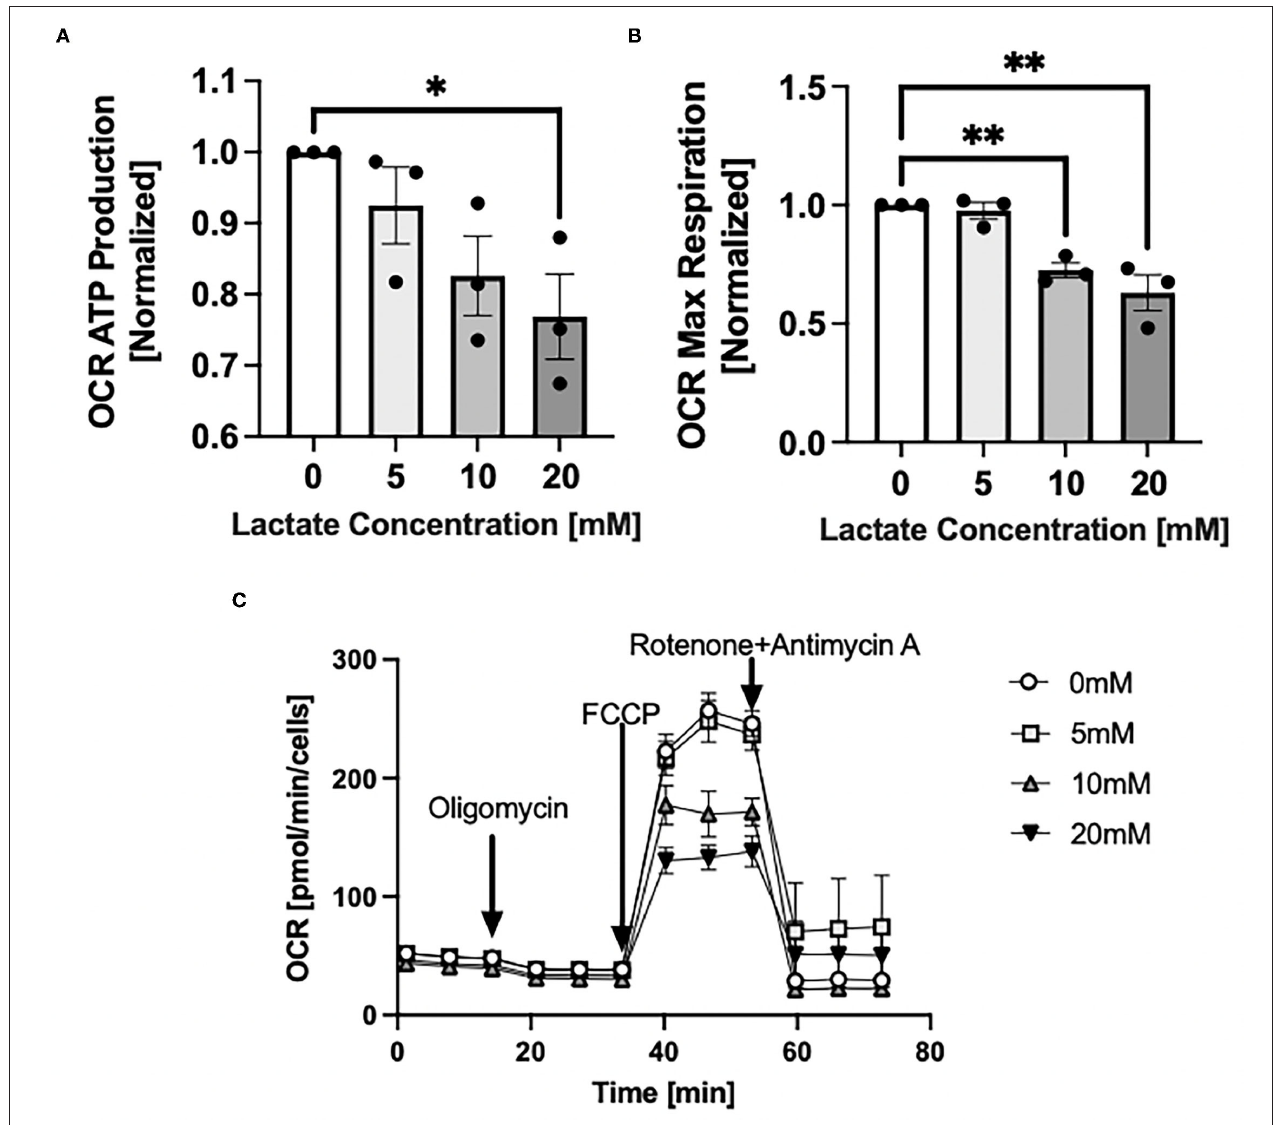
FIGURE 5 | Mitochondrial oxygen consumption rate with chronic lactate treatment. NRVMs were treated for 48h with various concentrations of lactate and oxygen consumption rate assessed using the Seahorse analyzer. (A) Rate of ATP production normalized to untreated cells (untreated range 8.5 to 16.3 pmol/min/cell), (B) Rate of maximal respiration normalized to untreated cells (untreated range 132.5 to 386.4 pmol/min/cell). (C) Seahorse trace for a representative NRVM preparation day. n = average of 3 cell preparations; error bars show standard error of the mean, * p < 0.05, ** p <